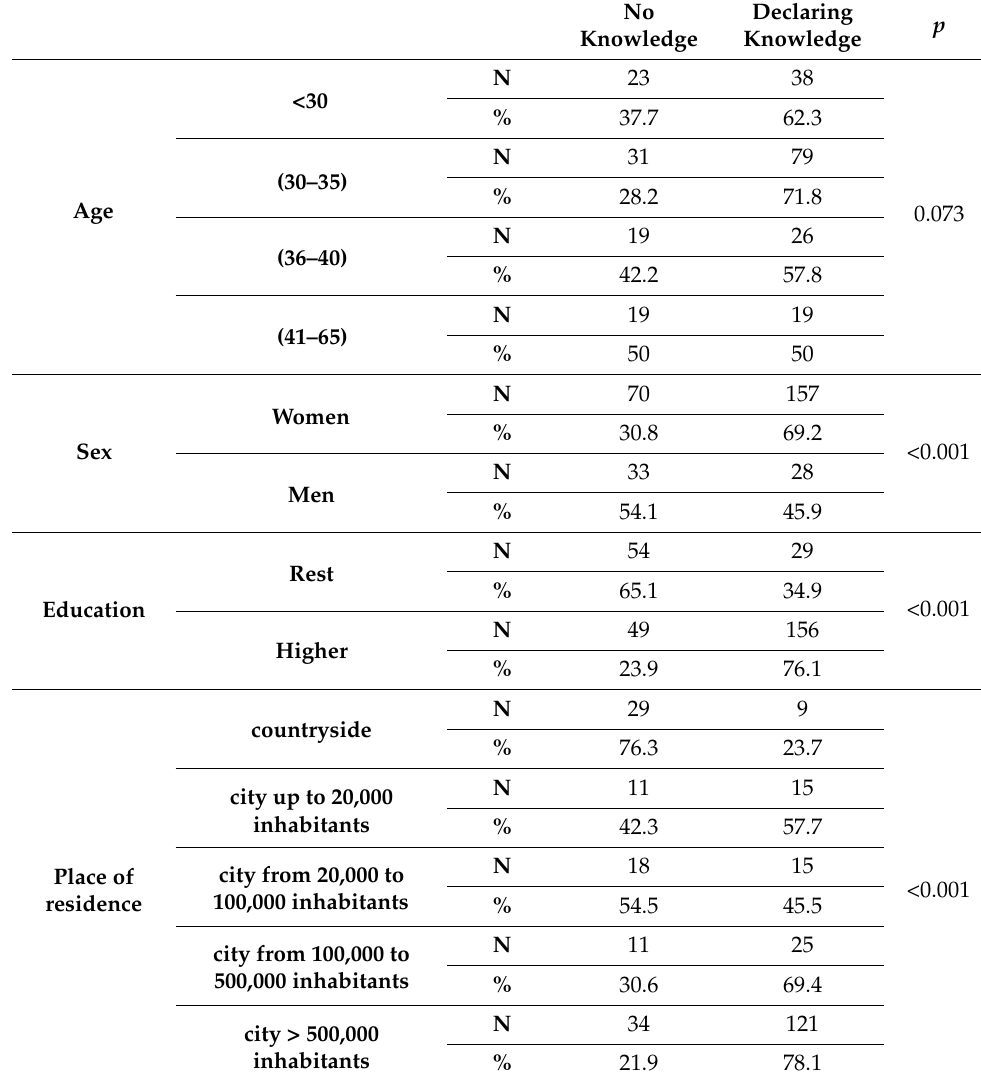
Table 2. Characteristics of the group of parents divided into two groups, declaring knowledge about HPV and HPV vaccination and declaring the lack of